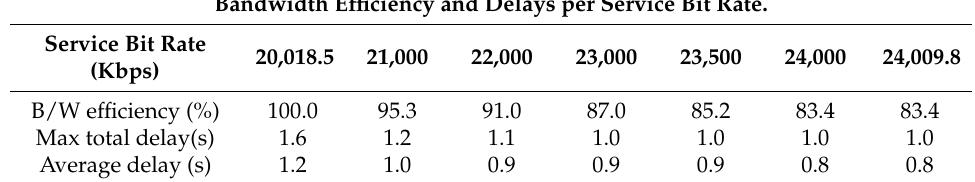
Figure 9. Simulation results of ‘DASH fast’. Table 9. Simulation results of ‘DASH fast’. Bandwidth Efficiency and Delays per Service Bit Rate.